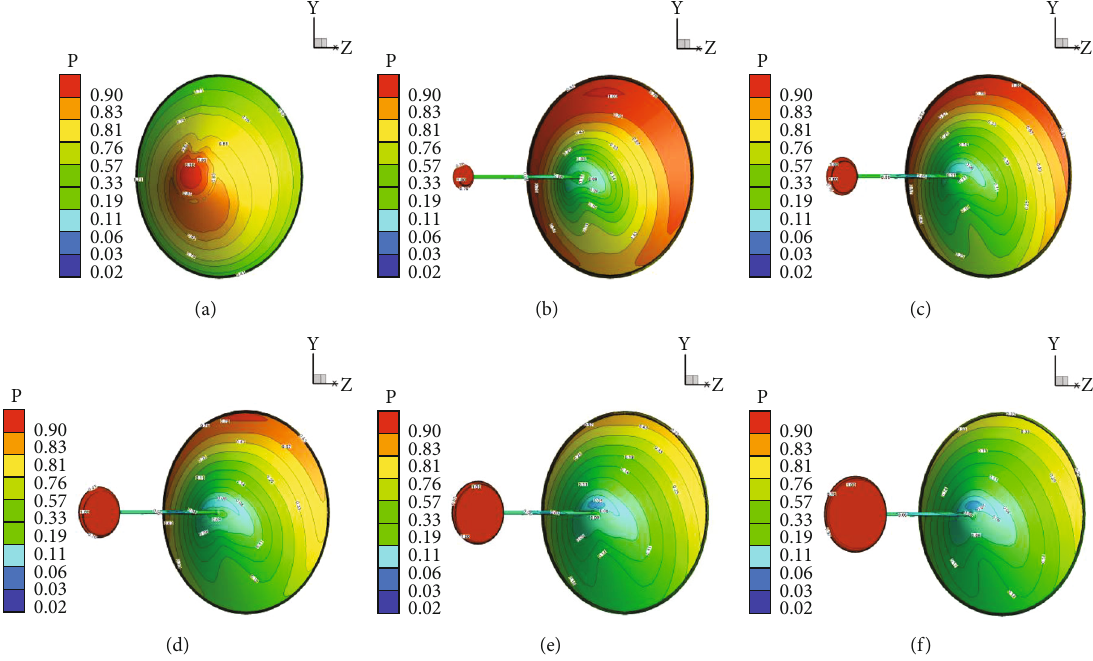
Figure 13: Wall pressure contour at a pitch angle of 0 ° . (a) d / D = 0 : 0 . (b) d / D = 0 : 125 . (c) d / D = 0 : 1875 . (d) d / D = 0 : 25 . (e) d / D = 0 : 3125 . (f) d / D = 0 : 375 .